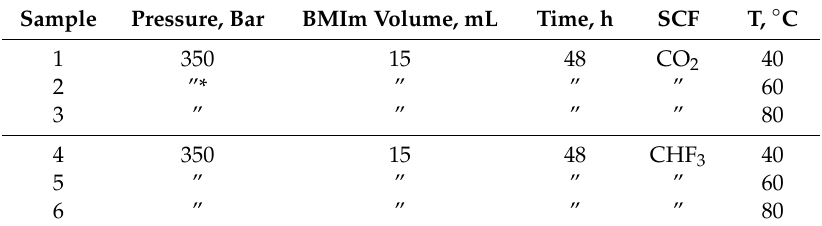
Table 1. Conditions for the quaternization of BMIm by PMP-Br films in the medium of CO 2 and CHF 3